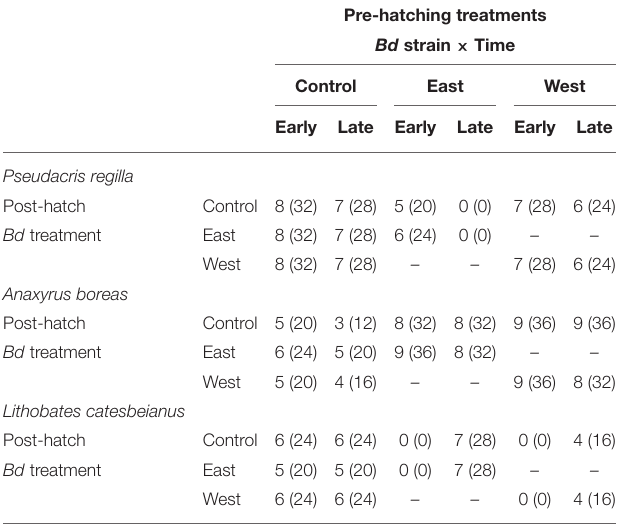
the Late/East treatment group ( t = − 11.03, p < 0.001) relative to the Late/West treatment ( t = − 1.29, p = 0.19). In fact, < 10% of embryos hatched after being exposed late in development to the non-native East strain ( Figure 2B ). In A. boreas , the proportion of embryos that hatched was similar across both strains in comparison to controls across the Early (East strain: t = – 0.49, p = 0.62; West strain: t = 0.62, p = 0.53) ( Figure 2C ) and Late exposure treatments (East strain: t = 1.31, p = 0.19; West strain: t = 0.73, p = 0.46) ( Figure 2D ). The proportion of L. catesbeianus embryos that hatched was low when embryos were exposed early in development, with lower survival in the West Bd strain treatment relative to controls (West strain: t = 3.58, p < 0.001) ( Figure 2E ). There were no survivors in the East strain exposure treatment. The estimate of Bd strain as a factor in our model was high (5,329), potentially due to the 100% mortality, making the t and p -value not significant ( t = 0.003, p = 0.99). The proportion of embryos that hatched in the Late exposure treatment was lower across both Bd strains in comparison to the controls (East strain: t = 2.89, p < 0.01; West strain: t = 2.13, p = 0.03) ( Figure 2F ). A post hoc Tukey test showed that this proportion was different in embryos exposed to the East strain in contrast to the control ( z = 2.89, p strain ( z = 2.13, p =